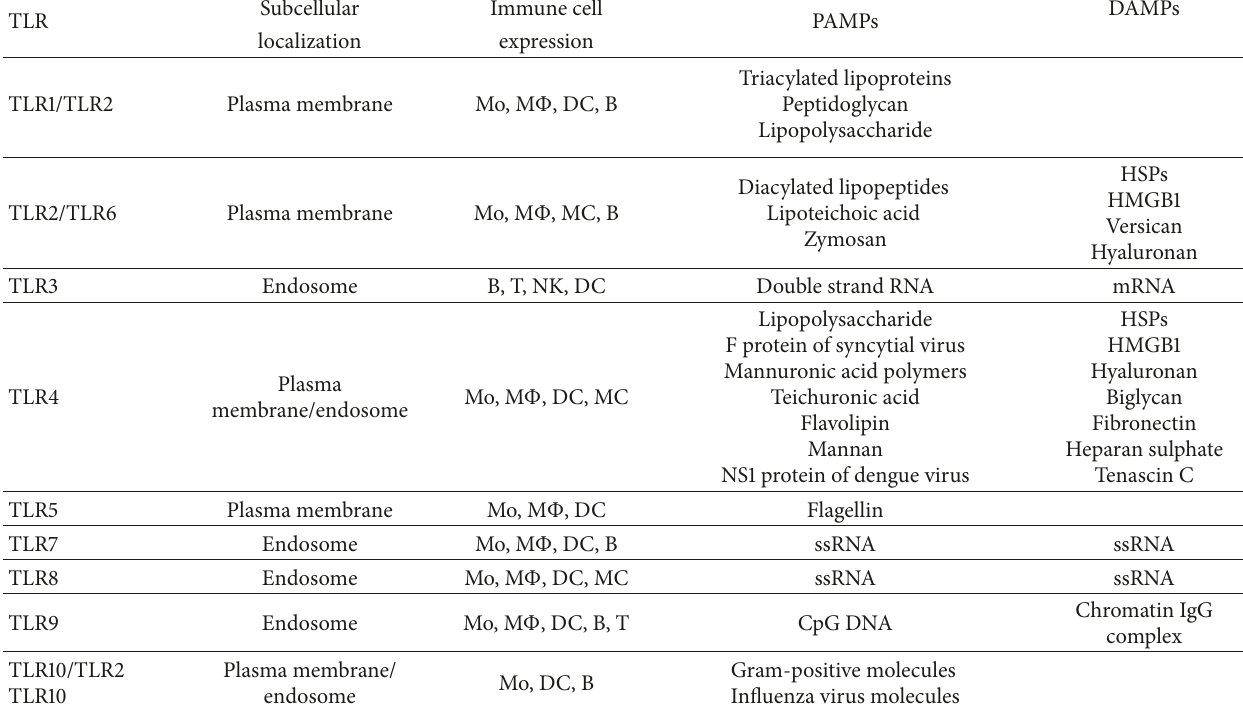
Table 1: Ligands and immune cells expressing Toll-Like Receptors. Mo, monocytes; M Φ , macrophages, DC, dendritic cells; MC, mast cells; B, B lymphocytes; T, T lymphocytes; NK, NK cells; HSPs, heat shock proteins; HMGB1, high mobility group box 1; mRNA, messenger RNA; ssRNA, single-stranded